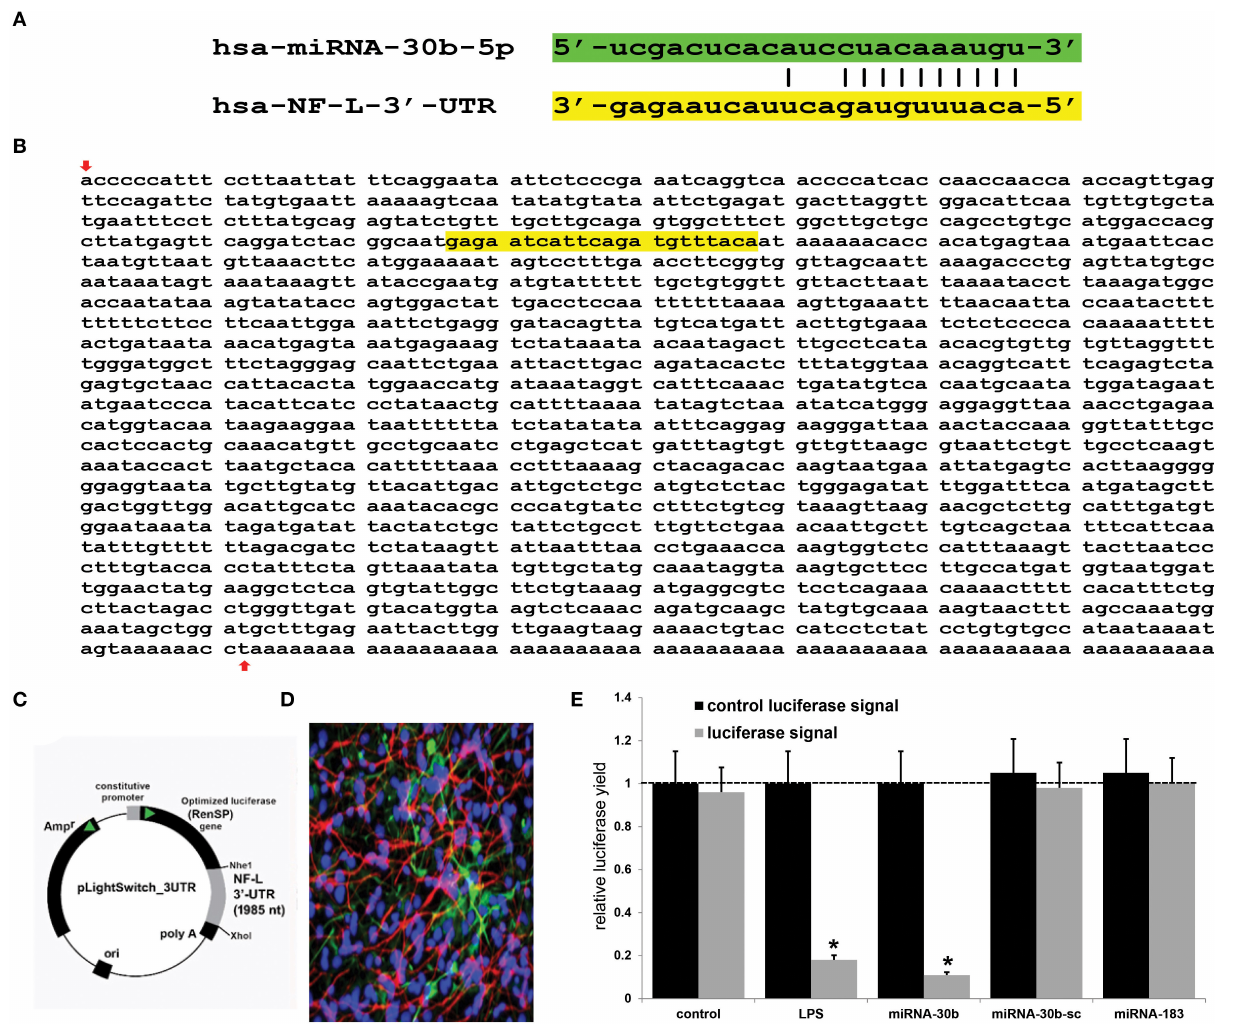
FIGURE 1 | Analysis of the hsa-miRNA-30b-5p (miRNA-30b) interaction with the Homo sapien NF-L 3’-UTR; (A) representation of the nucleotide complementarity between the 22 nucleotide (nt) hsa-miR-30b-5p (highlighted in green; encoded at the miRNA-30 gene cluster on human chromosome (chr) 8q24.22; https://www. genecards.org/cgi-bin/carddisp.pl?gene=MIR30B) and nt position 266–287 of the NF-L mRNA 3’-UTR non-coding region (highlighted in yellow; encoded at human chr 8p21.1; https://www.genecards.org/cgi-bin/carddisp.pl?gene=NEFL); the microRNA target prediction database (miRDB; http://mirdb.org/cgi-bin/targetdetail.cgi? targetID=2099169; last accessed April 24, 2022) for miRNA-30b and NF-L (NEFL; NCBI Gene ID 4747; GenBank Accession NM_006158) indicates a very high miRNA-mRNA target score of 84 and a strong 10 nt ‘seed’ sequence location at 278-287 nt of the NF-L 3’-UTR [see also “ (B) ” below]; (B) the NF-L 3’-UTR gene sequence; the inverted red arrow indicates the start of the NF-L 3’-UTR non-coding sequence; last upward pointing red arrow is the end of the NF-L 3’-UTR; note that additional adenosine groups are present in the mature NF-L mRNA (and 3’ end of the NF-L 3’-UTR); (C) the NF-L-mRNA-3 ′ -UTR expression vector luciferase reporter assay (pLight Switch-3 ′ UTR; Cat#S810535; Switchgear Genomics, Palo Alto CA); in this vector, the entire 1,985 nucleotide NF-L 3 ′ -UTR was ligated into the unique Nhe1-Xho1site; not drawn to scale; (D) human neuronal-glial (HNG) cells, 2 weeks in primary culture; neurons (red stain; λ max = 690nm), DAPI (blue nuclear stain; λ max = 470nm) and glial fibrillary associated protein (GFAP; glial-specific green stain; λ max = 520nm); the HNG cell culture is about 60% confluent and at 2 weeks of culture contains about 70% neurons and 30% astroglia (7, 14, 18, 39, 40, 49); human neurons do not culture well in the absence of glia; neurons also show both extensive cytoarchitecture and display electrical activity (unpublished; Lonza Research and Development, Walkersville MD, USA); 40X magnification; HNG cells transfected with the NF-L-mRNA-3 ′ -UTR expression vector luciferase reporter were treated exogenously with LPS (20ng/ml cell culture medium, 48 hr), a stabilized miRNA-30b, a scrambled control miRNA-30b (miRNA-30b-sc) or control miRNA-183; see (14, 18, 39, 49) and text for further details on all reagents and methods used in these experiments; (E) compared to control, HNG cells transfected with a scrambled (sc) control pLightSwitch-3’-UTR vector, the NF-L-mRNA-3 ′ -UTR vector exhibited decreased luciferase signal to a mean of 0.18-fold of controls in the presence of exogenous LPS and 0.11 in the presence of miRNA-30b; this same vector exhibited no change in relative luciferase yield in the presence of a control miRNA-30b-sc or miRNA-183; for each experiment (using different batches of HNG cells) a control luciferase signal was generated that included separate controls with each analysis; in addition a control vector β -actin-3 ′ -UTR showed no significant effects on the relative luciferase signal yield after treatment with either miRNA-183 or miRNA-30b (data not shown); a dashed horizontal line set to 1 is included for ease of comparison; N = 5; * p < 0.01 (ANOVA); values represent mean + /- 1 standard deviation (S.D.); Microsoft Excel Analysis ToolPak, Excel for Microsoft 365; https:// support.microsoft.com/en-us/office/use-the-analysis-toolpak-to-perform-complex-data-analysis-6c67ccf0-f4a9-487c-8dec-bdb5a2cefab6. The results suggest